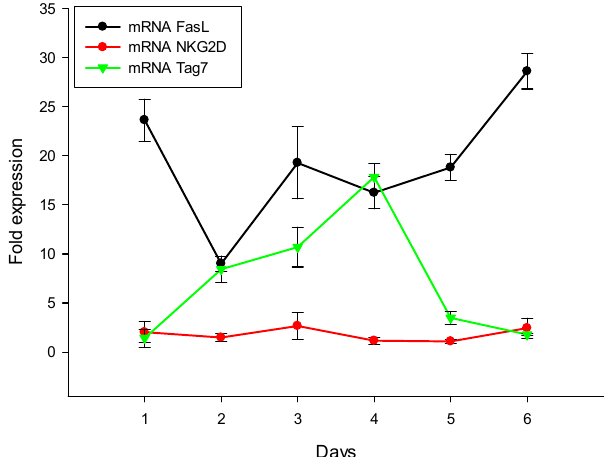
Figure 7. N3 peptide increases mRNA level of receptors of cytotoxic lymphocytes: FasL, NKG2D and Tag7 in PBMCs during 6 days of treatment. All values were normalized to control (before any treatment). Levels of mRNA were measured by RT-PCR. RPLP/GADPH were used as reference.